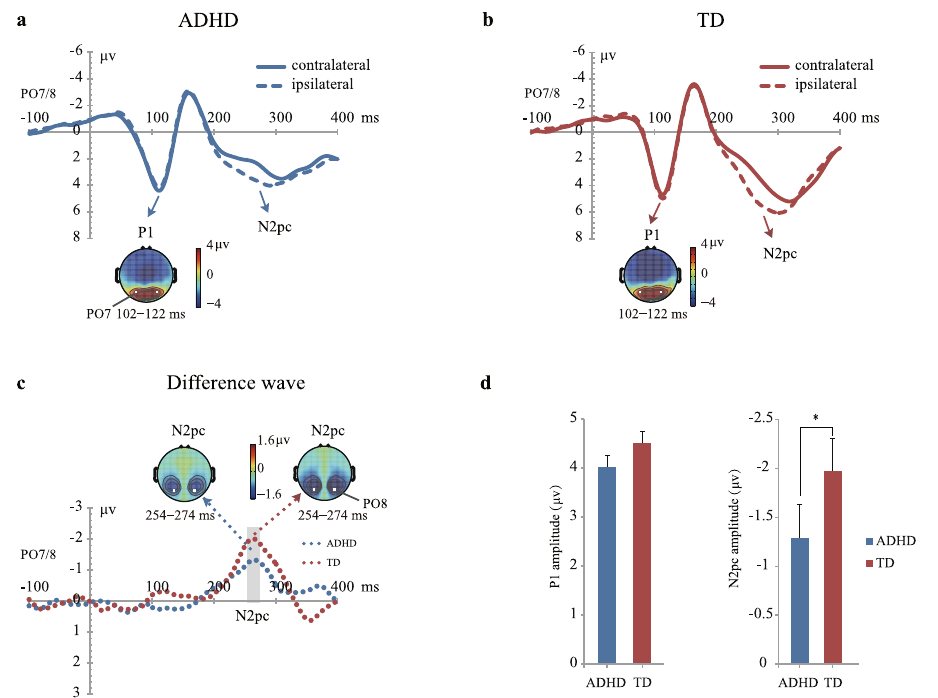
Figure 2. Grand averaged event-related potentials (ERPs) at contralateral and ipsilateral electrode sites (averaged over PO7 and PO8) relative to the target in children with ADHD ( a ) and TD children ( b ). Grand average difference waveforms ( c ) obtained by subtracting ipsilateral from contralateral waveforms. Topographic scalp maps show the distribution of P1 and N2pc components. The schematic illustration in ( d ) shows the mean voltages (and SE) of P1 and N2pc of ADHD and TD